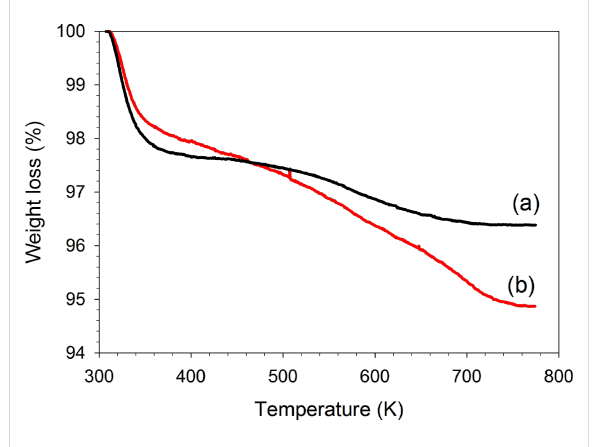
Figure 10: The TGA weight loss curves V-Ti/MCM-41 photocatalyst using O 2 as the sweep gas: (a) fresh catalyst and (b) catalyst deacti- vated by the photo-epoxidation of